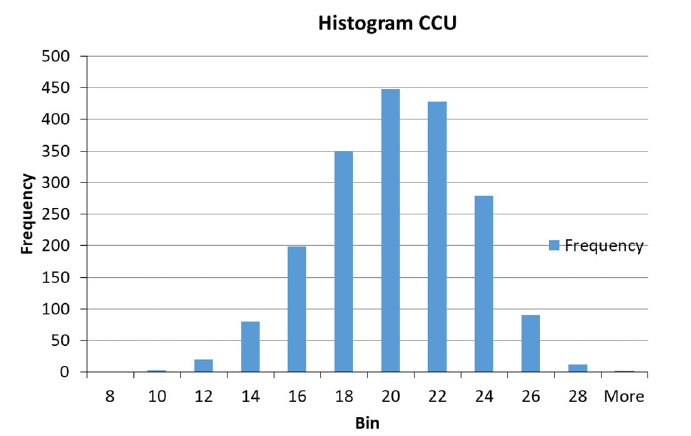
Figure A11. Copper content in final concentrate (CCU)—dataset distribution.